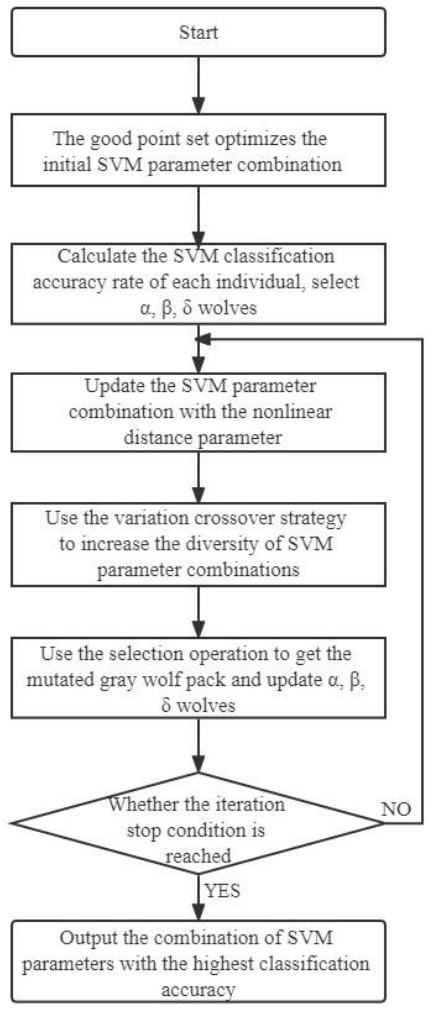
Figure 10. Improved Grey Wolf Algorithm to Optimize SVM Parameter Combination Process.